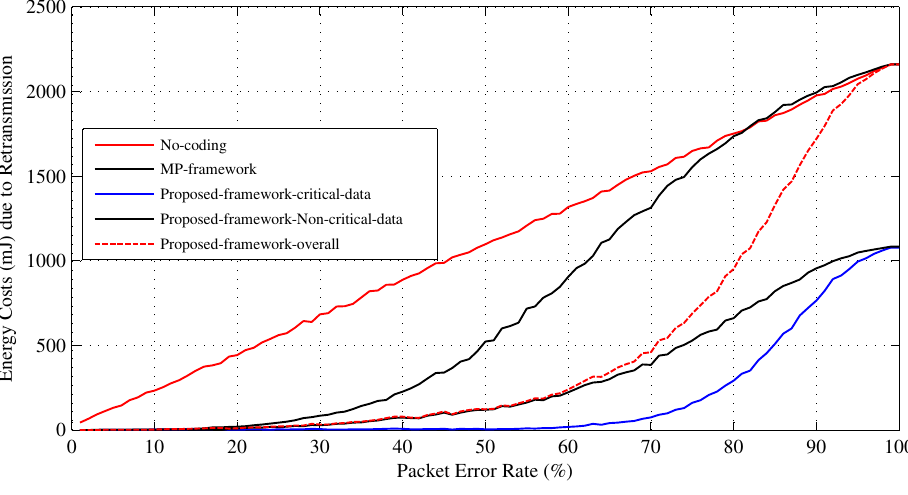
Figure 12. Energy consumed due to the retransmissions.